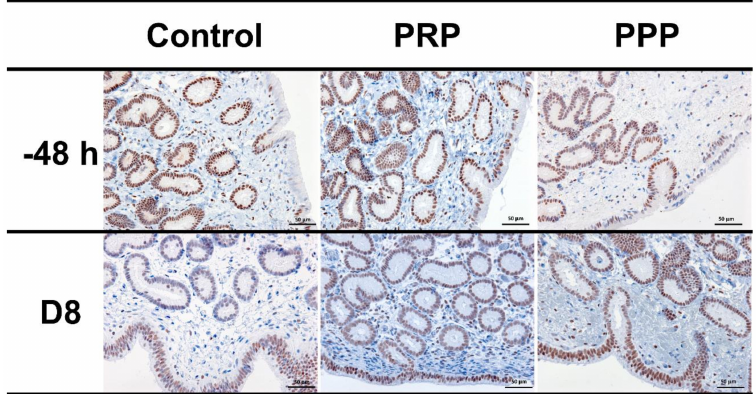
Figure 5. Representative images of immunohistochemical PR expression in uterine biopsies (200 × magnification) from mares susceptible to persistent breeding-induced endometritis pre-breeding ( − 48 h) and on the day of embryo flushing (eight days post-ovulation, D8). Mares were treated with four intrauterine infusions of Lactated-Ringer’s solution (Control), platelet-rich (PRP), or -poor plasma (PPP). Positive nuclei to PR were brown-stained, while negative nuclei were blue stained by hematoxylin